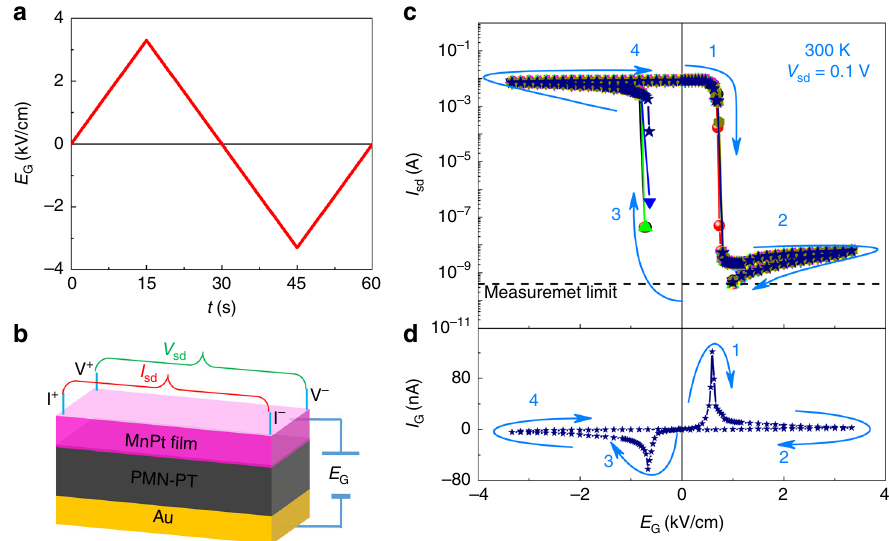
Fig. 2 Colossal electrical switching at room temperature. a Electrical waveform for creating cracks in PMN-PT. b Schematic of the resistance measurement geometry. c Repeated and reproducible switching of the channel current I sd as a function of the gate electric fi eld E G , measured by V sd = 0.1 V at 300 K. The data for nine continuous cyclic fi eld loops are plotted (data connecting segments 2 and 3 are not shown because they are below the measurement limit). d Corresponding switching current in the PMN-PT substrate of the last scan. The arrows and numbers in c and d are the guidance of the fi eld-sweep represented in Fig. 2b. At E G = 0 kV/cm, a fi xed voltage of V sd =